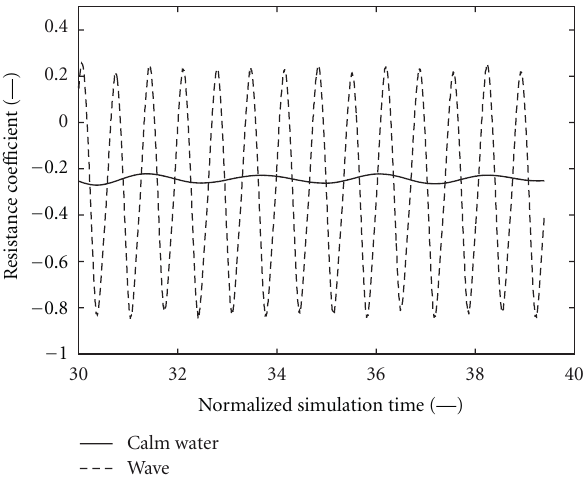
Figure 19: Time history of the computed resistance coe ffi cient ( R T / ( ρn 2 D 4 )).